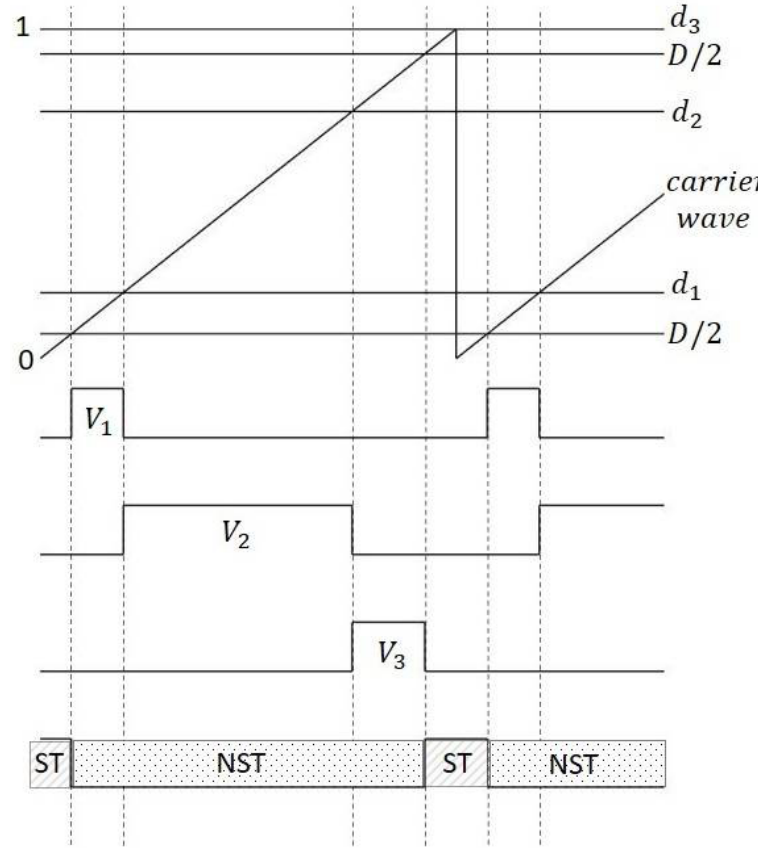
Figure 4. SVPWM strategy for qZSI Filter.